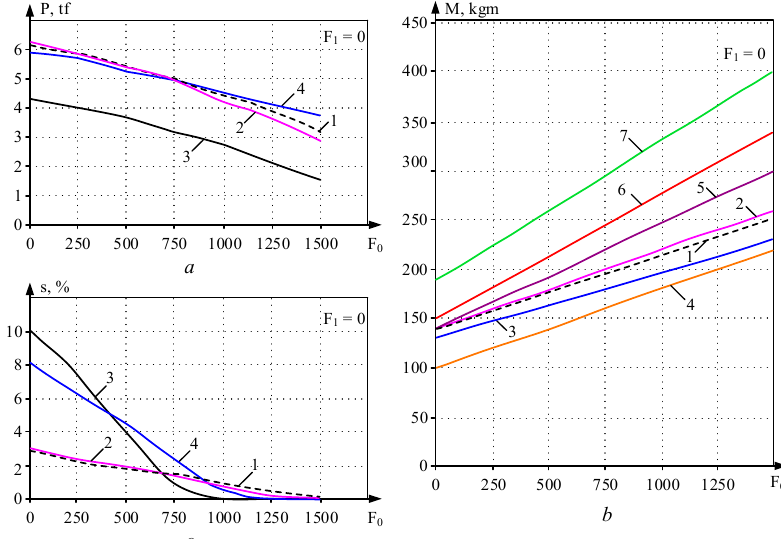
Figure 10. Dependencies similar to Figure 9, ( a ), torque ( b ) and flow ( c ) from rear